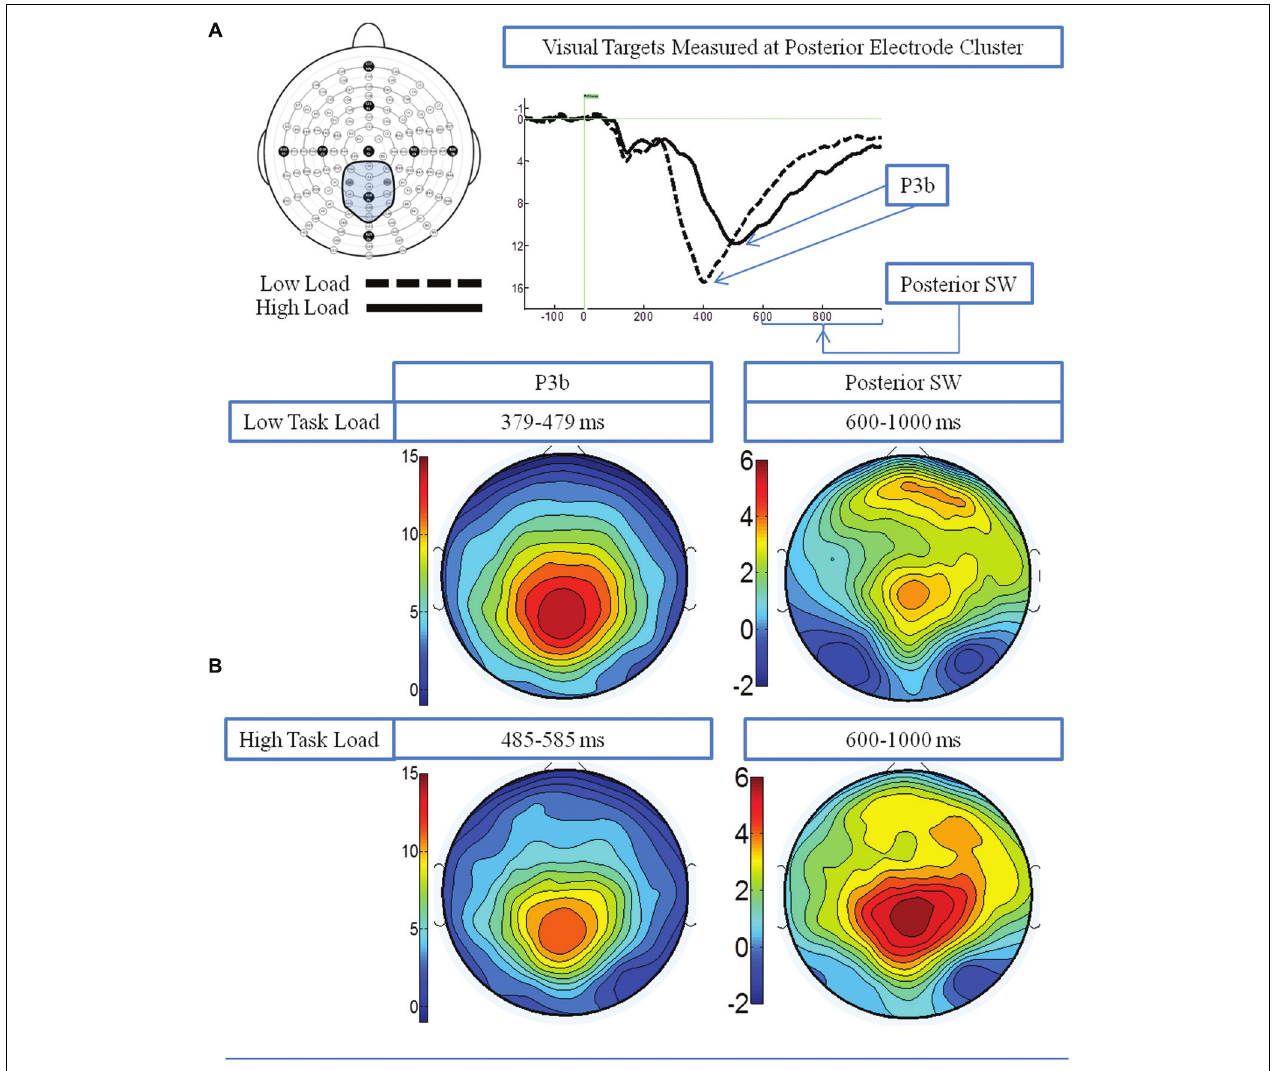
FIGURE 2 | Event-related potential (ERP) data in response to target visual stimuli under the low and high load conditions. (A) Illustrates the grand average waveforms (arrows point to the P3b component and posterior SW); and (B) shows the surface potential maps for the P3b component and the posterior